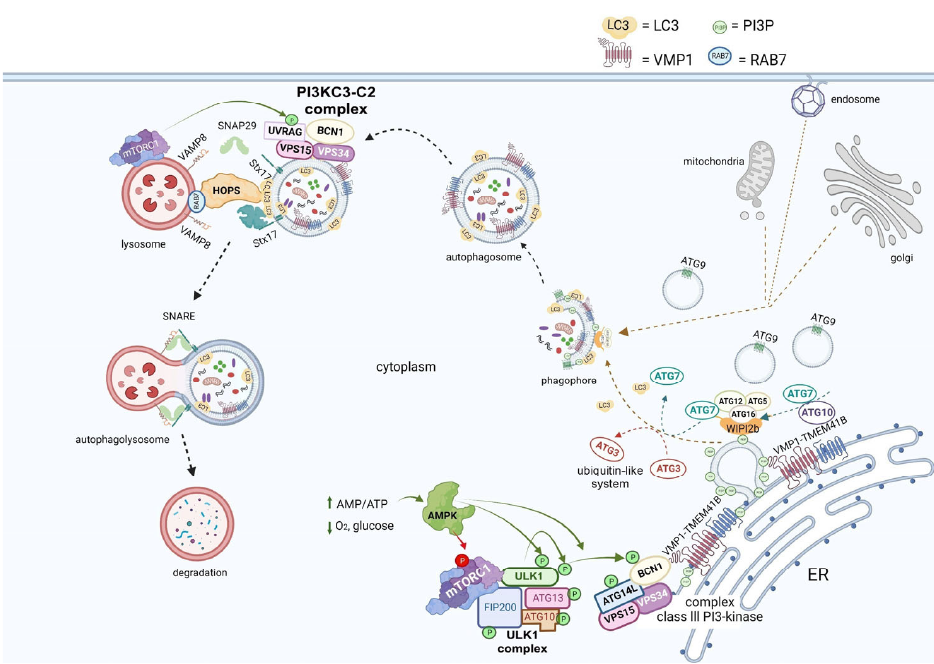
Figure 2. Autophagy overview diagram flow . Autophagy can be initiated by a lack of nutrients, implying amino acid, glucose, or O2 depletion, or an AMP/ATP increase, as a result. When AMPK is activated, it inhibits the mTORC1 complex and activates the ULK1 complex through phosphorylation. Autophagosome biogenesis is mediated by ULK1 activation and translocation to ER. Thus, the class III PI3-kinase complex is activated by the phosphorylation of BECN1 and ATG14L; this process leads to a PI3P production increase through catalytic subunit VPS34 activation; transmembrane protein VMP1 interacts with BECN1 and WIPI2b protein is recruited. WIPI recruits ATG16L-ATG5-ATG12, a ubiquitin-like system, on the isolation membrane, mediating LC3 lipidation on the membrane. LC3 plays a crucial role in the whole autophagy process. The transmembrane protein ATG9 is implied in vesicular trafficking towards the phagosome maturation area. Once the autophagosome is mature, the second complex, PI3KC3-C2, replaces ATG14L by UVRAG, which is activated by mTORC1 and participates in autophagosome–lysosome fusion. This fusion is regulated by the HOPS complex. STX17 interacts with lysosomal VAMP8 through SNAP29, constituting the SNAREs, forming the autolysosome structure. The complexes highlighted in this figure are as follows: complex ULK1 (ULK1-ATG13-FIP200-ATG10); complex class III PI3-kinase (BECN1-ATG14L-VPS34-VPS15); complex PI3KC3-C2 (BECN1-UVRAG-VPS34-VPS15). Figure was created with